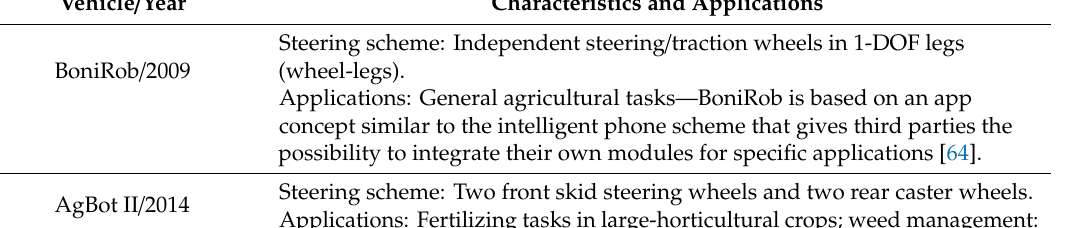
Table 3. Agriculture autonomous robots based on specific structures. Characteristics and